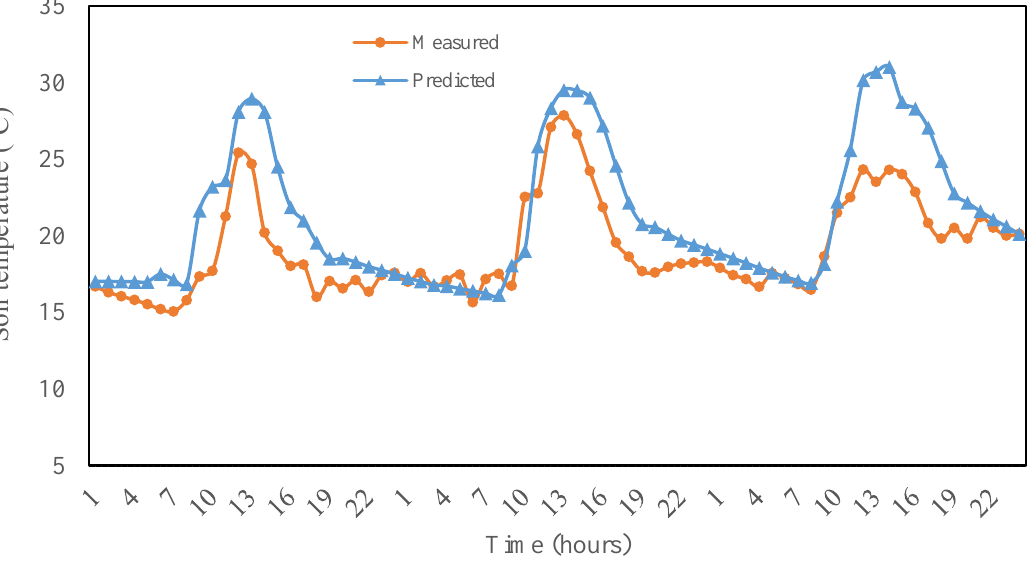
Figure 9. The comparison of the measured and predicted soil temperature near the surface.